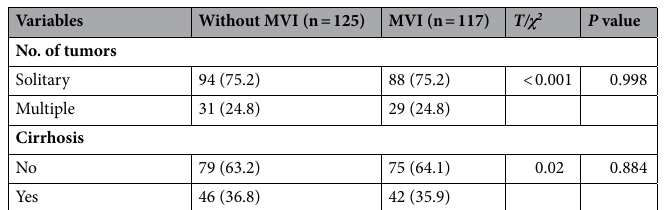
Table 3. Univariate analysis of MVI presence based on preoperative data in HCC patients. MVI microvascular invasion, HbeAg hepatitis B e antigen, HBV hepatitis B virus, ALT alanine aminotransferase, AST